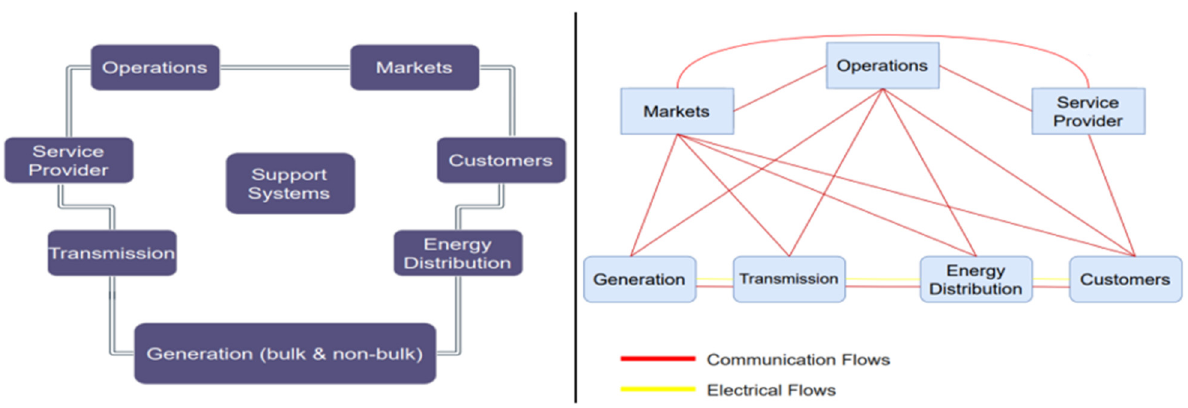
Figure 4. Smart grid domains and communication paths between smart energy grid